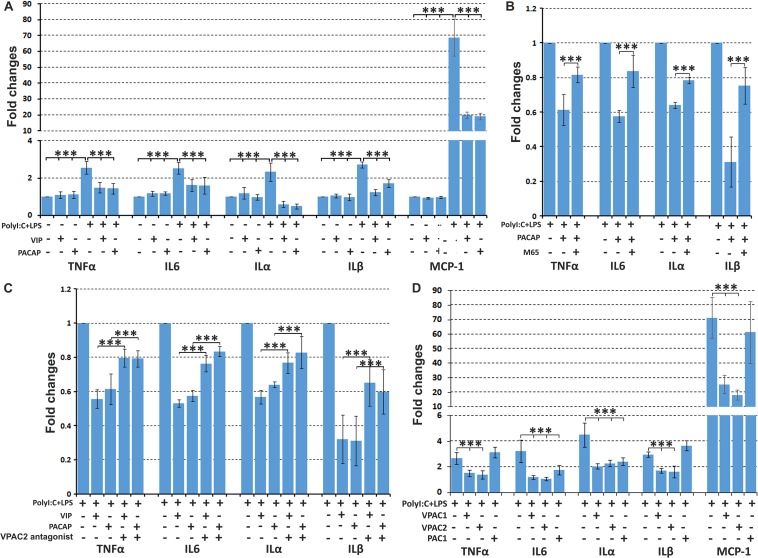
VIP and PACAP inhibit pro-inflammatory cytokine expression in cultured Schwann cells. (A) VIP and PACAP inhibit Poly:IC and lipopolysaccharide (LPS) induction of TNFα, IL6, ILα, ILβ, and MCP-1 expression in Schwann cells. (B) PAC1 receptor antagonist (M65) pre-treatment (1 h before adding PACAP) inhibits PACAP function. (C) VPAC2 receptor antagonist pre-treatment (1 h before adding VIP and PACAP) inhibits VIP and PACAP function. (D) VPAC1 and VPAC2 receptor specific agonist inhibits TNFα, IL6, ILα, ILβ, and MCP-1 expression in Schwann cells induced by PolyI:C and LPS stimulation. Note that PAC1 receptor specific agonist inhibits IL6 and ILα but not TNFα, ILβ, and MCP-1 expression. All samples were normalized to GAPDH and control samples were normalized to 1. n = 4. ∗∗∗P < 0.001.